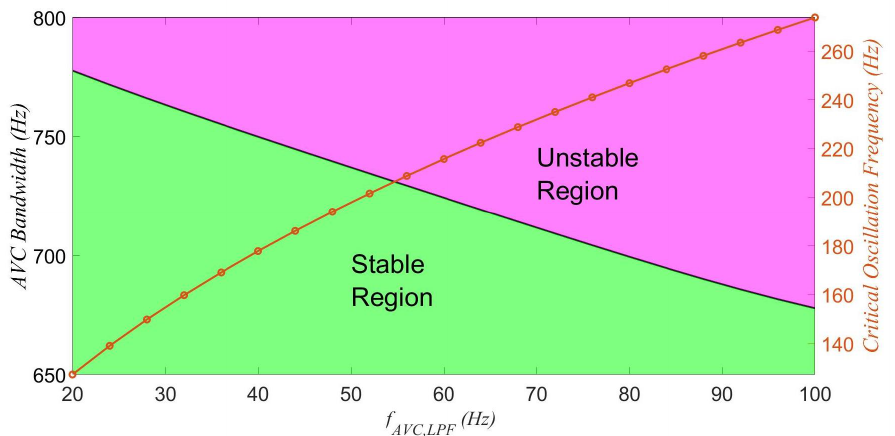
Figure 14. Stability regions of the AVC bandwidth in a strong grid case (SCR = 10), when f AVC,LPF varies from 20 to 100 Hz. The corresponding critical oscillation frequency to the critical AVC band- width is shown